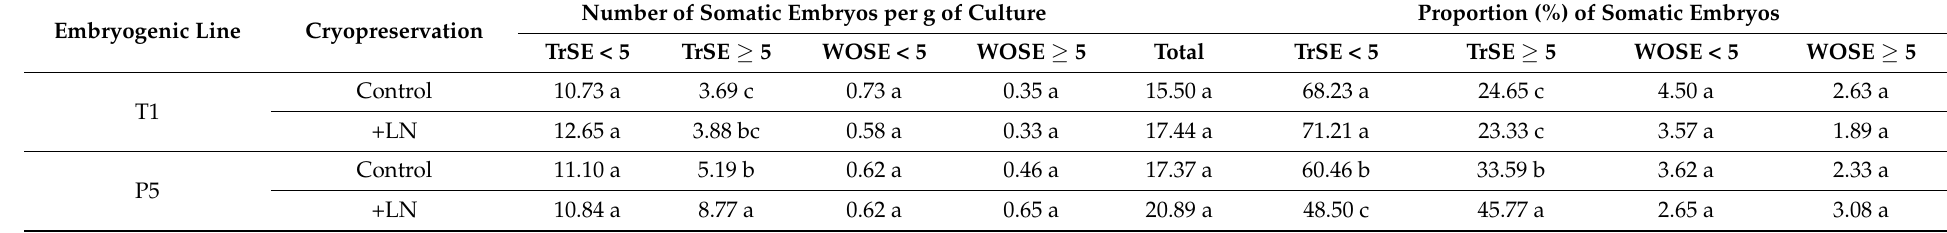
Table 2. Effect of cryopreservation on the capability of embryogenic cultures of the lines T1 and P5 to produce somatic embryos at different developmental stages during the maturation phase. Production of somatic embryos at different developmental stages expressed per gram of culture and proportionally with respect to the total number of embryos obtained. Data assessed eight weeks after initiation in maturation conditions. Different letters indicate significant differences by the LSD test with a significance level of